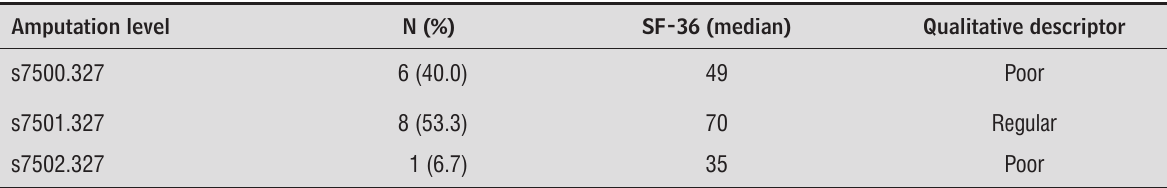
Table 5 - Quality of life according to the level of